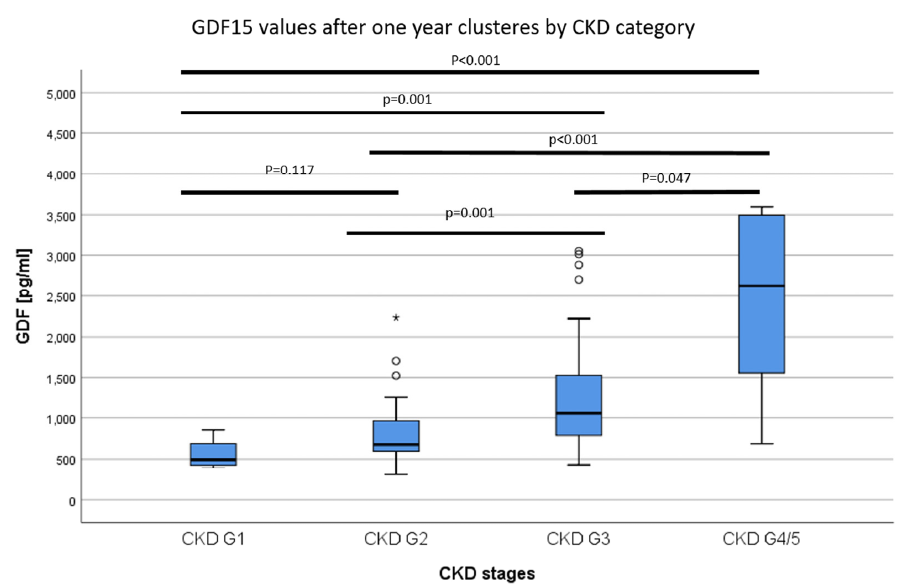
Figure 6. The GDF15 values of recipients one year after KTx clustered by CKD stage. GDF15 values were increased depending on the CKD category.